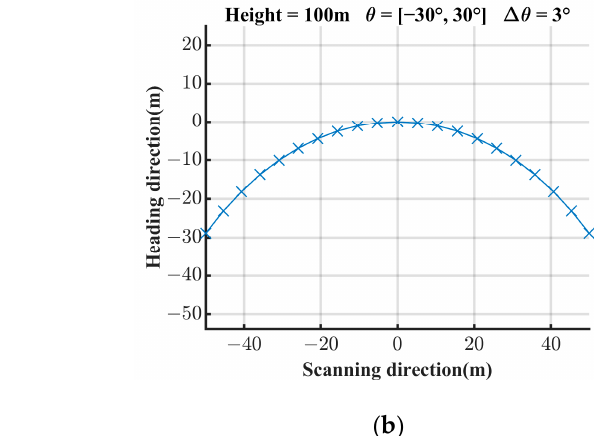
Figure 6. Quadrangular tower mirror scanning mode 1. ( a ) Scanning schematic diagram; ( b ) Scan- ning track with a height of 100 m, a motor rotation angle of ±30° , and an interval angle of 3° be- tween points.